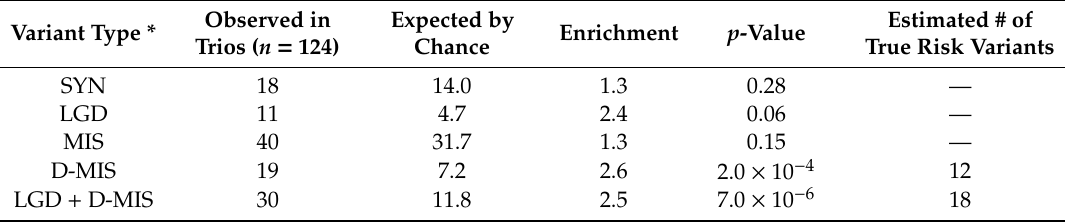
Table 3. Burden of de novo variants in 5756 genes highly expressed in developing lung (murine E16.5 lung stromal cells) and / or developing heart (murine E14.5 heart) in pediatric-onset PAH ( n = 124 child / parent trios).